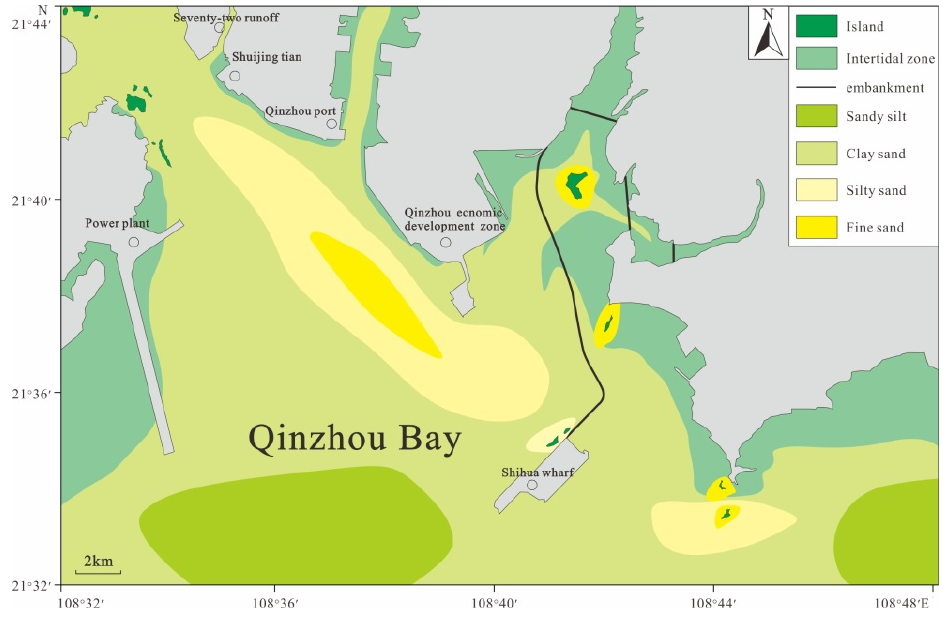
Figure 6. Distribution of sediment types in the research area. The light minerals in the sediments from Qinzhou Bay are mainly composed of quartz, feldspar, and detrital minerals. The quartz is mostly sub-angular with a content of 75–85% (Table 2). The color of the quartz is light isabelline, maroon, or milky white. The tidal flat sediments mainly contain light isabelline and maroon quartz, whereas the outer bay sediments mainly contain light green, yellow, and shallow-colored quartz. The feldspar is mostly columnar with contents of 11–17%. The color of the feldspar is light isabelline and light brown in most cases. The detrital minerals primarily consist of quartz and feldspar, with its content varying substantially. The detrital minerals content is relatively high in near-shore reefs and tidal channels (~15%), whereas it is extremely low in sediments of the sand bodies on both sides of the bay mouth. Table 2. Comparison of light mineral contents in the surface sediments between outer Qinzhou Bay and the Qinjiang River. Quantity Percent by Volume/% Source Quartz Potash Feldspar Albite Rock Detrital Minerals Research zone (range)